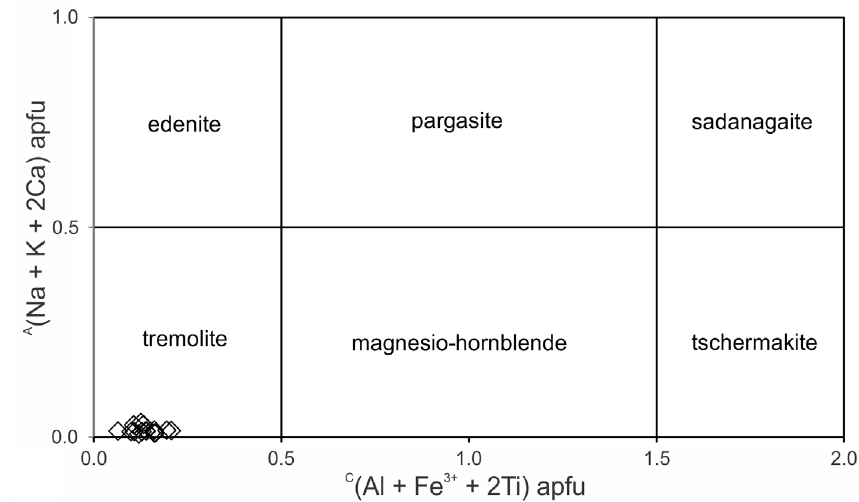
Figure 8. C (Al + Fe 3+ + 2Ti) versus A (Na + K + 2Ca) diagram for calcium amphiboles. Results of 15 analyzed spots by EPMA. Classification fields after Hawthorne et al.